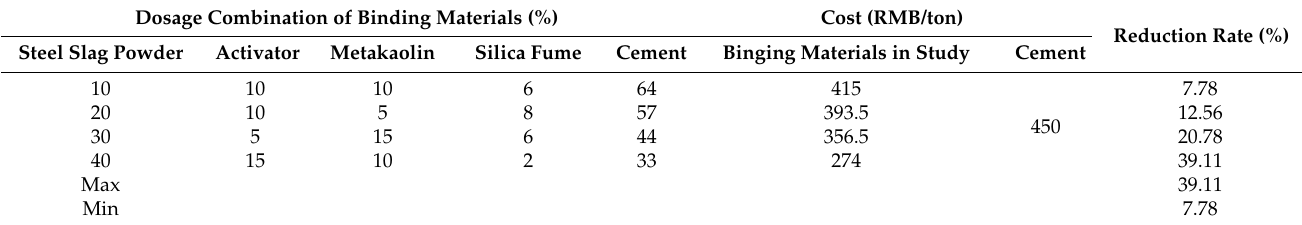
Table 13. Economic benefit analysis on the combination with highest flexural strength in each steel slag powder dosage level. Dosage Combination of Binding Materials